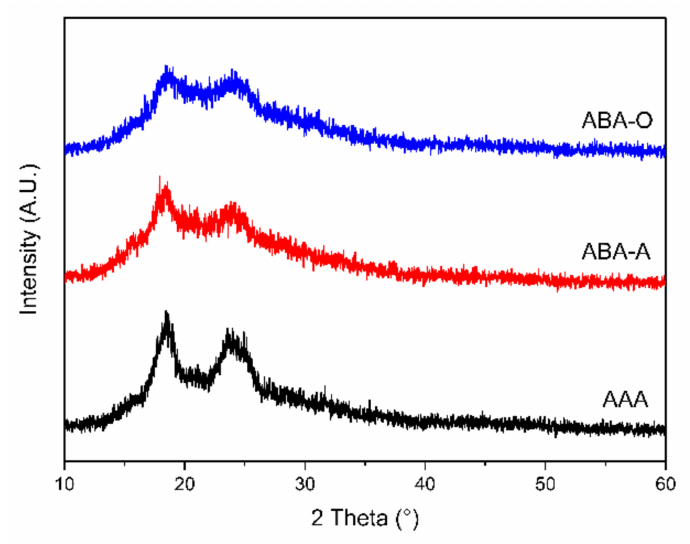
Figure 3. X-ray diffraction diagram of three polymers.